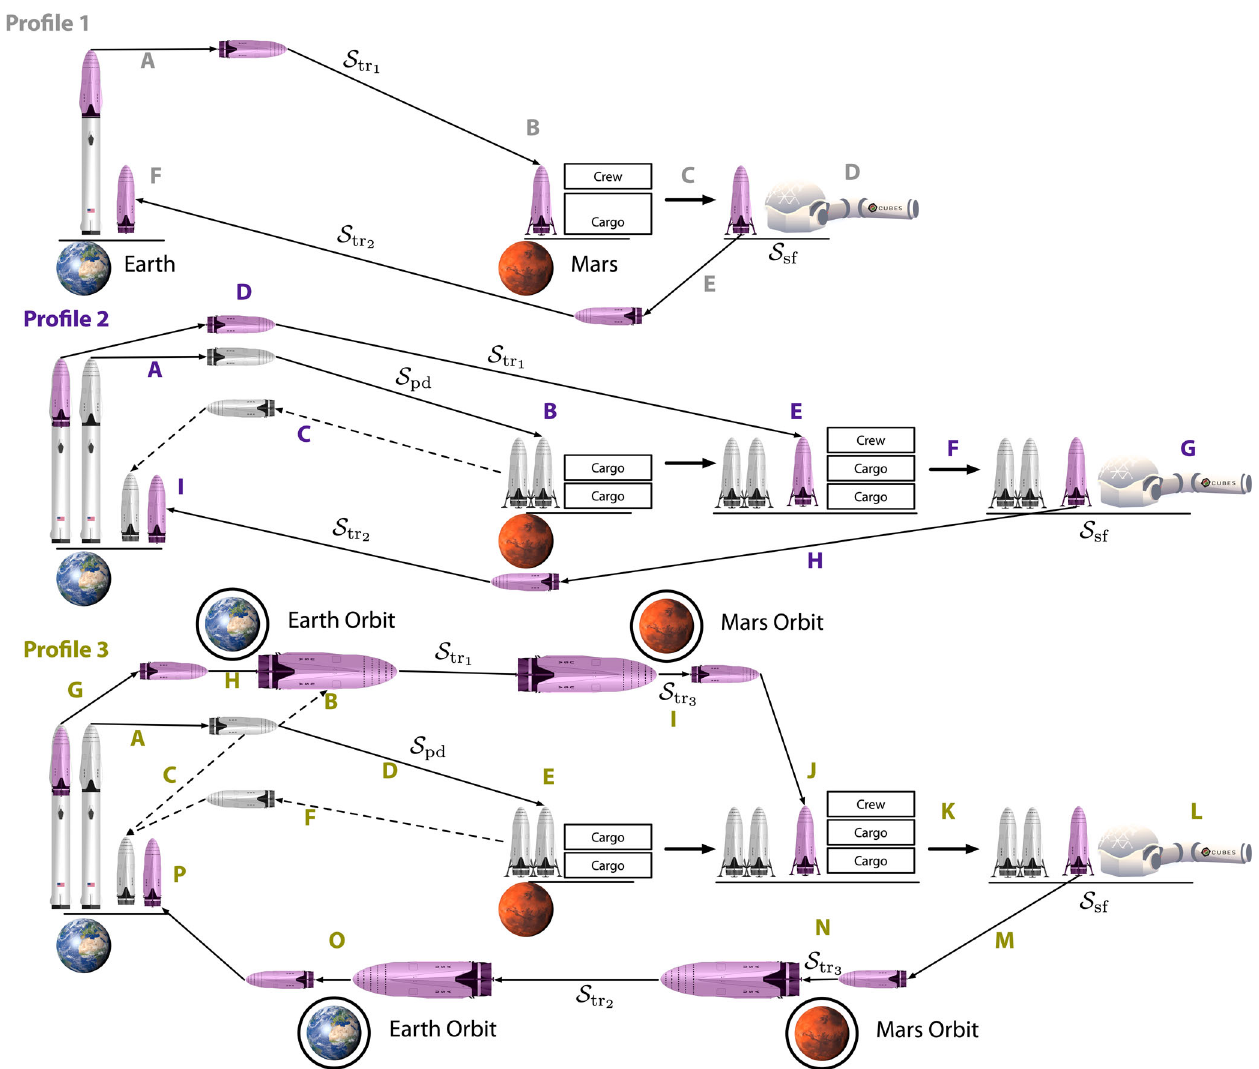
Fig. 1 Transit diagram of proposed mission architecture. In Pro fi le 1 (gray), A a crewed transit ship is launched directly from the surface of Earth and B lands on the surface of Mars where C the crew assembles the cargo in habitat and carries out D surface operations until E the crew launches from their initial transit ship from the surface of Mars into space and F lands back on the surface of Earth. In Pro fi le 2 (purple), A cargo transit ships without crew are launched directly from the surface of Earth and B land on the surface of Mars where cargo can be unloaded. In the case of reusable rocket systems 73 , C the cargo rockets can be launched from Mars and returned to Earth. Once all the cargo has been loaded onto the surface of Mars, D a crewed transit ship is launched directly from the surface of Earth and E lands on the surface of Mars where F the crew assembles the cargo in habitat and carries out G surface operations until H the crew launches from their initial transit ship from the surface of Mars into space and I lands back on the surface of Earth. In Pro fi le 3 (green), a number of A cargo transit ships without crew are launched directly from the surface of Earth and either B supply a previously interplanetary rocket then C return to the surface of Earth or D travel to the surface of Mars where E cargo can be unloaded. In the case of reusable rocket systems, F the cargo rockets can be launched from Mars and returned to Earth. Once all the cargo has been loaded on the surface of Mars, G a crewed transit ship is launched directly from the surface of Earth to Earth Orbit H where it rendezvous with an interplanetary rocket which I travels to Martian orbit. The crew J then boards a descent vehicle and lands on the surface of Mars where K the crew assembles the cargo in habitat and carries out L surface operations until M the crew launches from their initial transit ship from the surface of Mars into N Martian orbit where they again rendezvous with their interplanetary rocket which travels to O Earth orbit at which point they board a descent rocket in which they P fi nally return to the surface of different Δ v . Each element in the location mapping L 2 has a speci fi c required Δ v . Any segment describing operations in a single location, such as Martian surface operations, has no mass transport and thus will have a L eq = 1.0. Since Δ v can be related to the speci fi c impulse I sp and mass fraction m 0 / m f via the Tsiolkovsky rocket equation 1 , we see how the mass of a speci fi c segment inventory affects the location factor term. In terms of speci fi c calculations, the mass fraction is the ratio of the of initial total rocket mass m 0 to fi nal total mass m f , and the payload